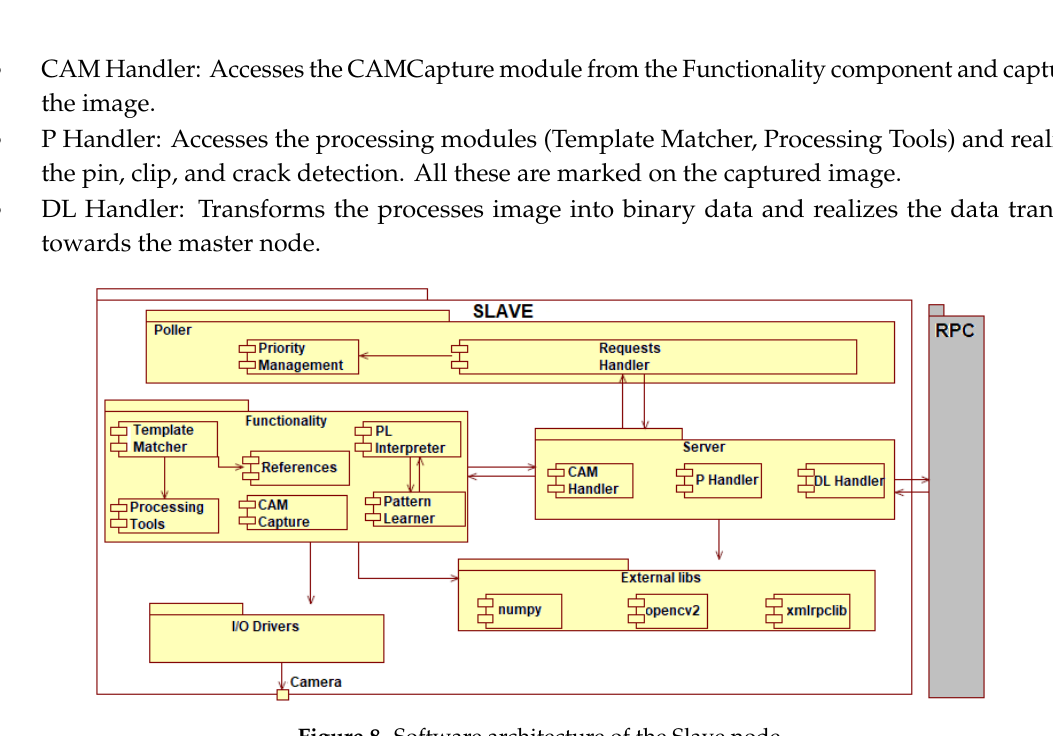
Figure 9. Slave node diagram of activities.